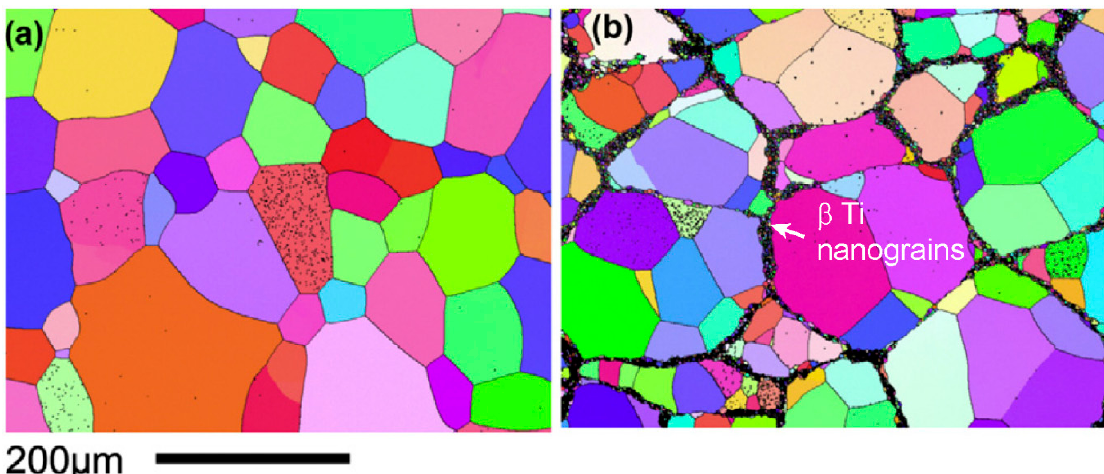
Figure 10. SEM electron back-scattered diffraction inverse pole figure maps of the β -Ti phase comparing the coarse grain microstructure of a material conventionally processed ( a ), to the harmonic microstructure, consisting of large grains surrounded by nanograins, of a material processed by SPS ( b ) [48]. Reproduced with permission from Scripta Materialia , published by Elsevier, 2017.